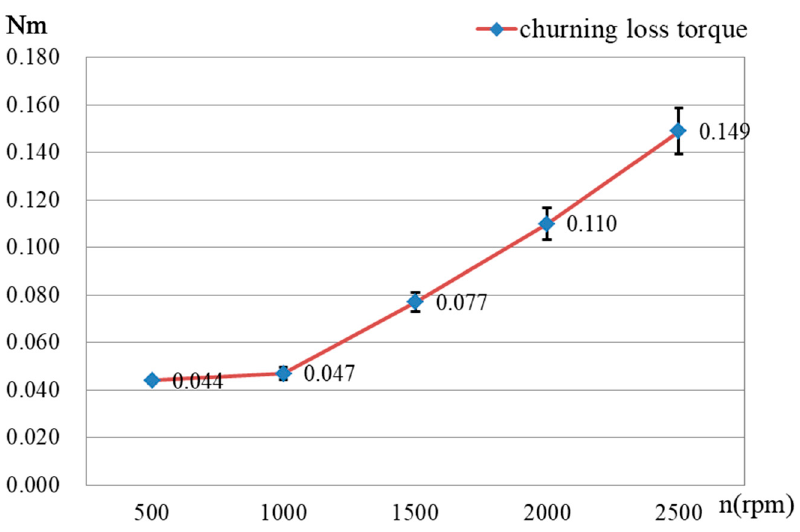
Figure 10. Average churning loss torques with rotational speeds.